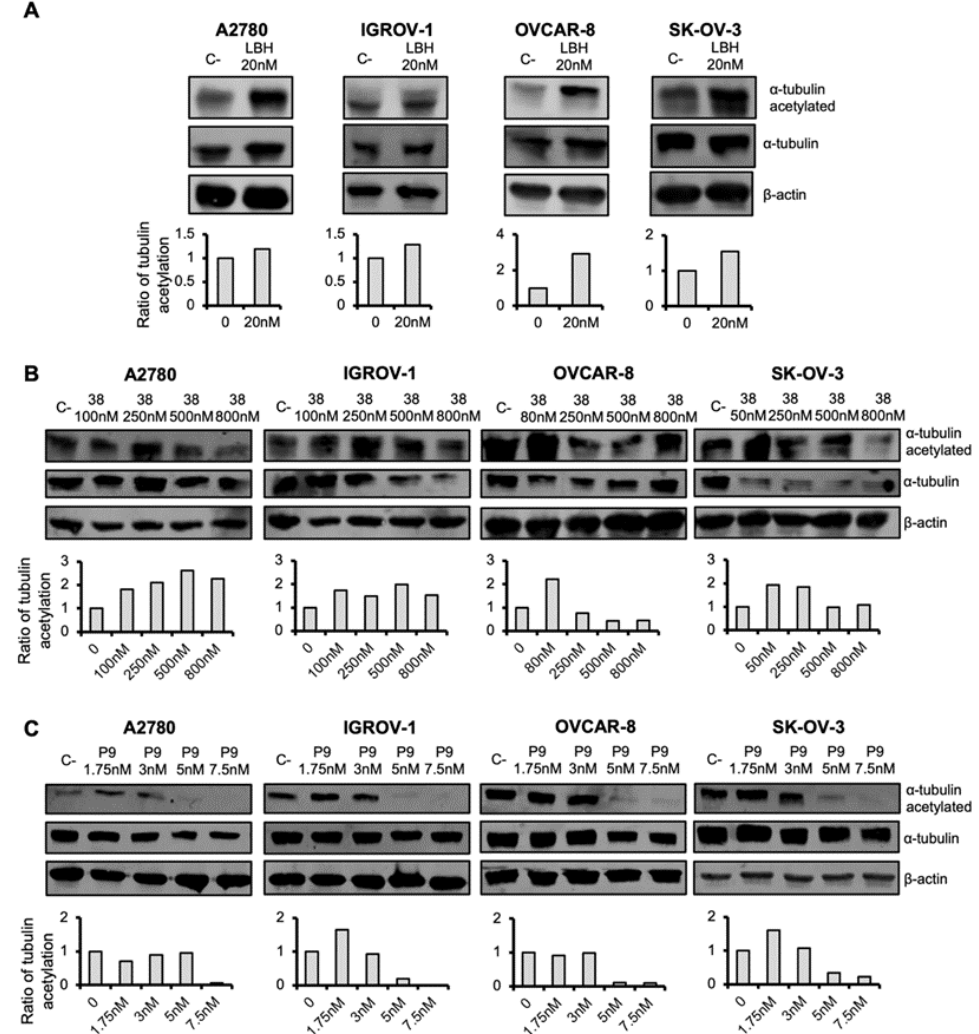
Figure 6. Effect of LBH and microtubule-destabilizing agents on tubulin acetylation. OC cells were treated with the indicated concentrations of LBH ( A ), 38 ( B ), or PILA9 ( C ) for 24 h or left untreated (C-) and the levels of total α -tubulin and acetylated α -tubulin were detected by western blot. β -actin was used as a loading control. Protein levels were quantified using ImageJ. Graphs represented the normalized ratios of acetylated α -tubulin over total α -tubulin, using β -actin levels to normalize. Untreated cells (C-) levels were taken as